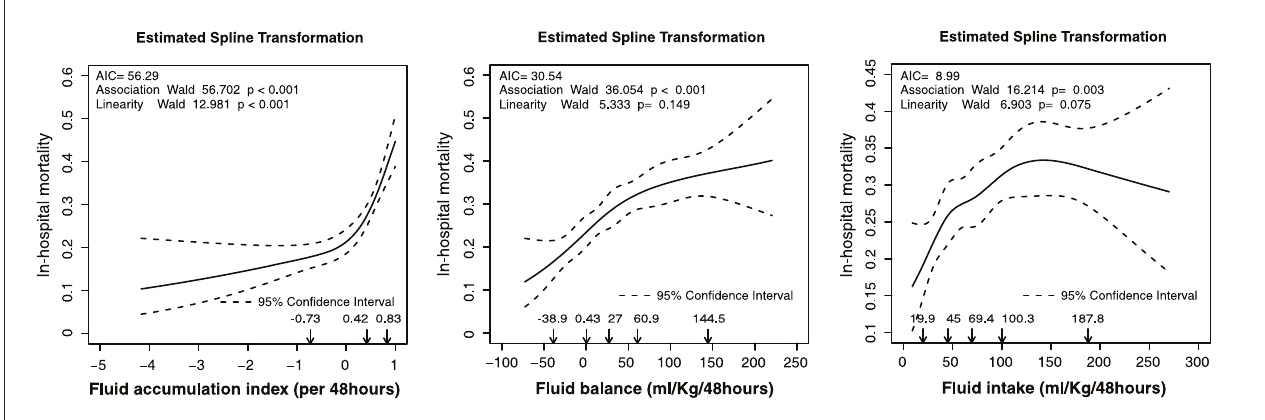
FIGURE 1 | Estimated spline transformation of FI, FB, and FAI for in-hospital mortality. AIC, Akaike information criterion; FAI, fluid accumulation index; FB, fluid balance; FI, fluid